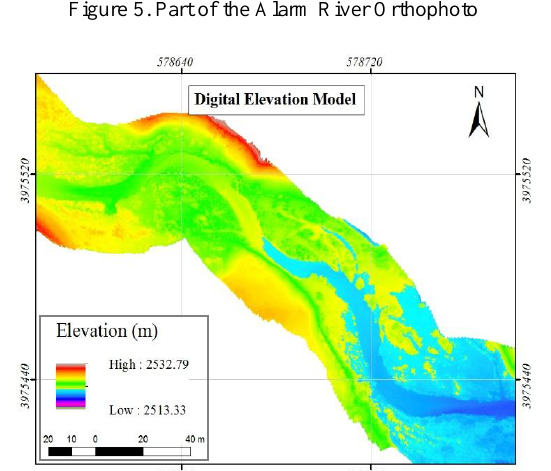
Figure 5. Part of the Alarm River Orthophoto